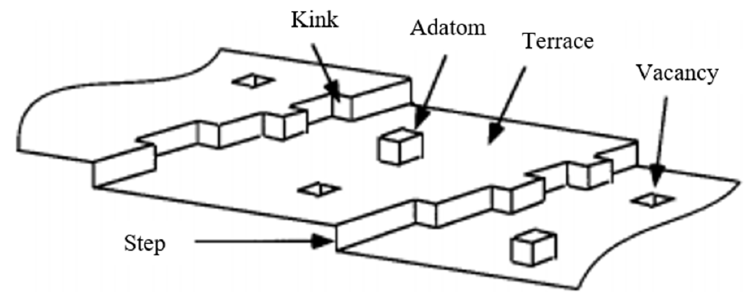
Figure 3. Simple block model of defects on a single-crystal surface. Reprinted with permission from Reference [9]. Copyright 2021 American Chemical Society.